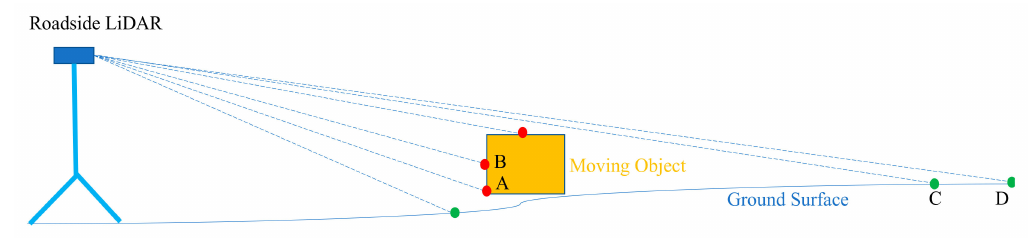
Figure 3. Slope di ff erence created by moving object and ground